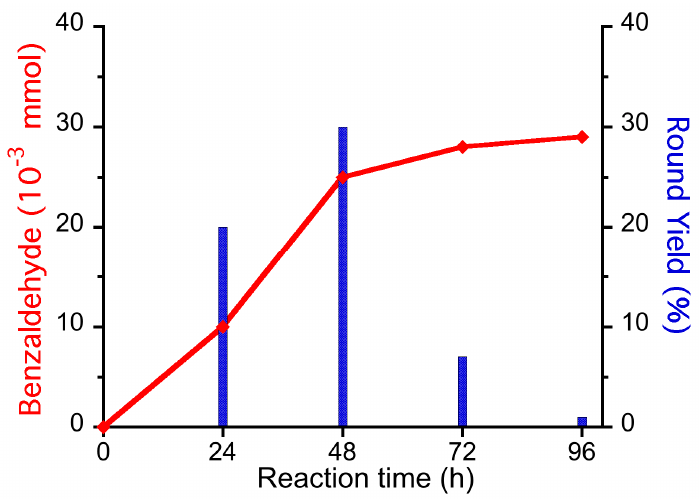
Figure 2. Recycle tests for the selective toluene oxidation to benzaldehyde under O 2 atmosphere in a biphasic system PhCH 3 -H 2 O. Conditions: V = 20 mL; PhCH 3 :H 2 O 1:1 v/v , pH = 1, H 2 O 2 0.05 mmol, NH 4 VO 3 0.025 mmol at 25 °C.